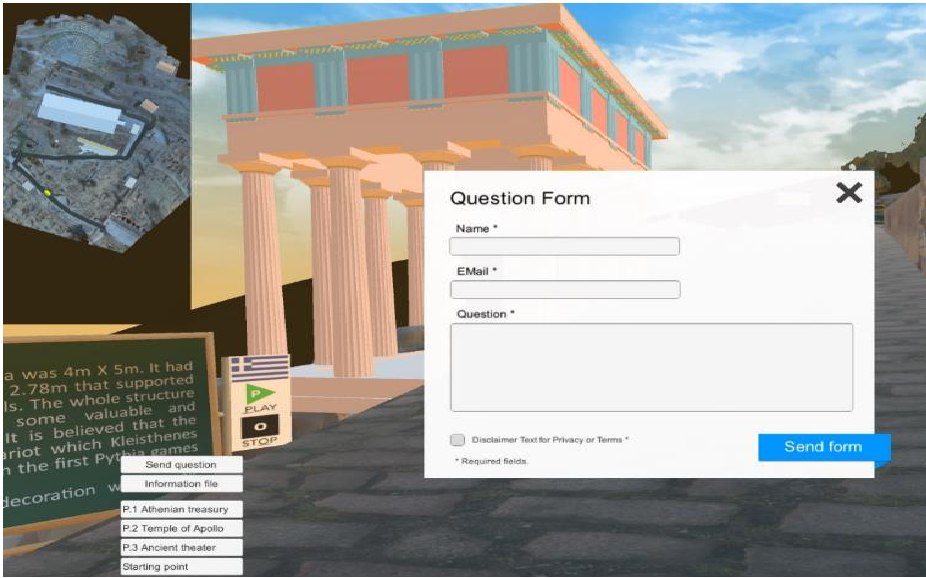
Figure 5. Final Software Version and Query Form of the route in the sanctuary (© Authors).